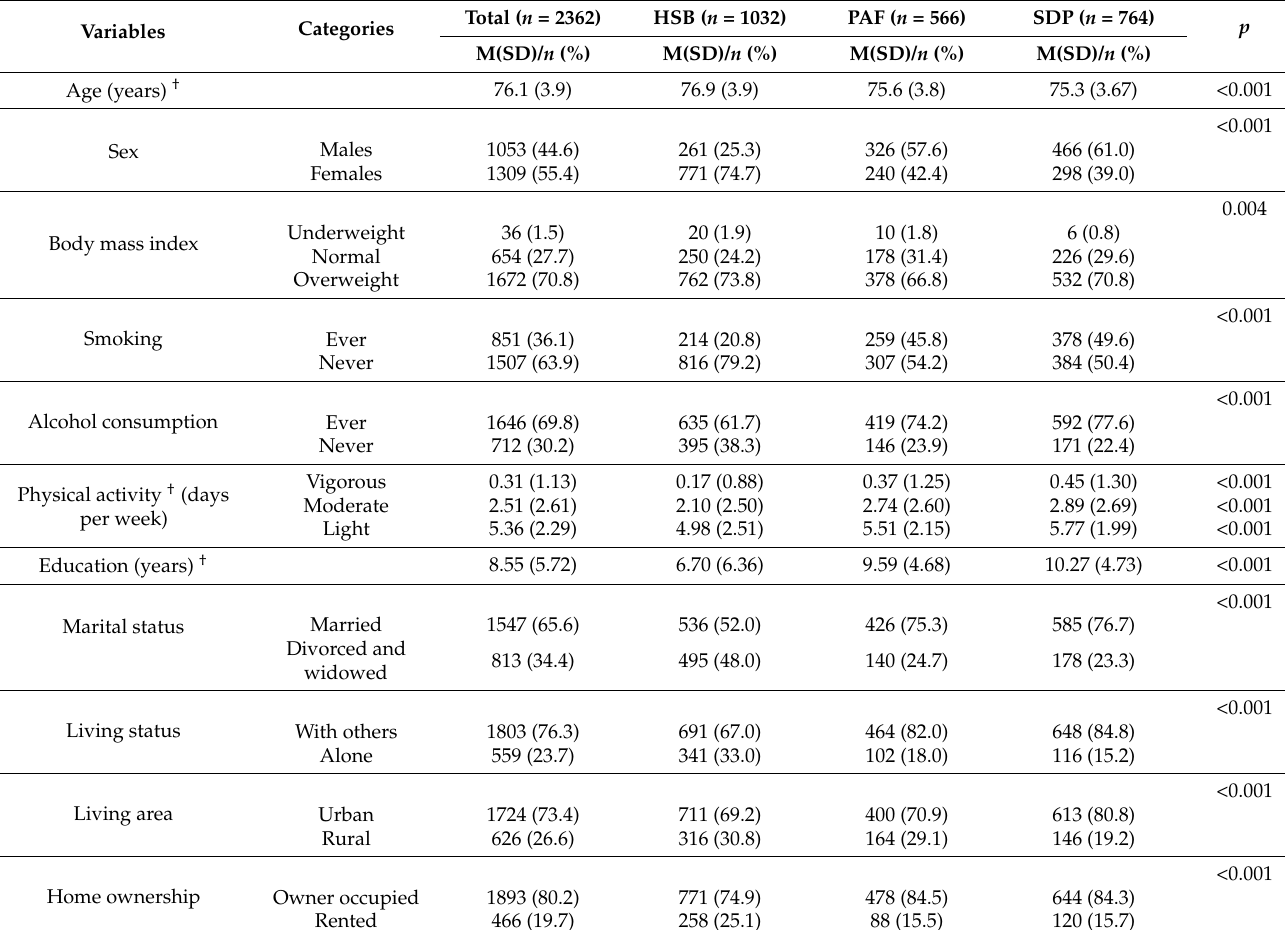
Table 1. Demographics and general characteristics of the symptom cluster